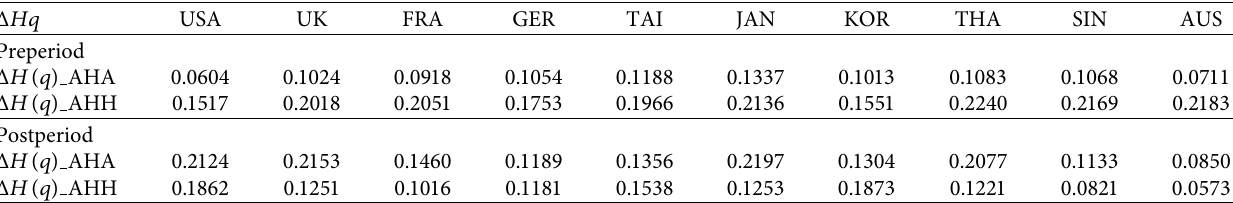
Table 2: Multifractal degree Δ Hq based on the